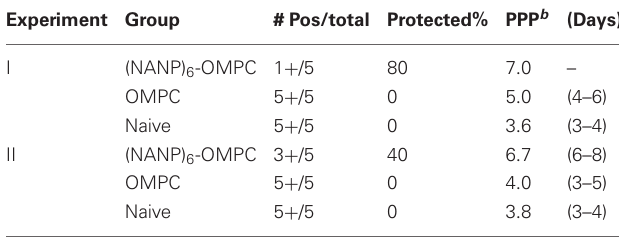
FIGURE 5 | Parasite levels in murine liver following challenge by bites of infected mosquitoes. Parasite 18S rRNA copy numbers in liver extract obtained at 40h post challenge by bites of 5–15 PfPb-infected mosquitoes was determined by qPCR. Results are shown for five mice in each group.